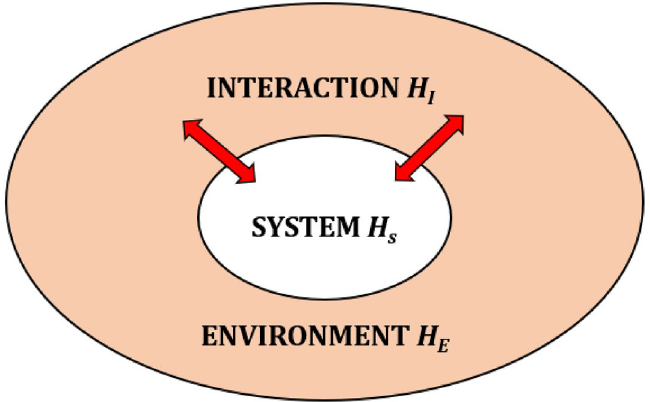
Figure 2. A schematic illustrating the concept of an open quantum system, including the Hamiltonians (H) that mathematically describe the system and environment as well as the interaction between the two. Biological systems interact with their environments and thus are often modelled using an open systems approach. This involves modelling the system and environment as a closed system, the environment is then traced out to arrive at the reduced system